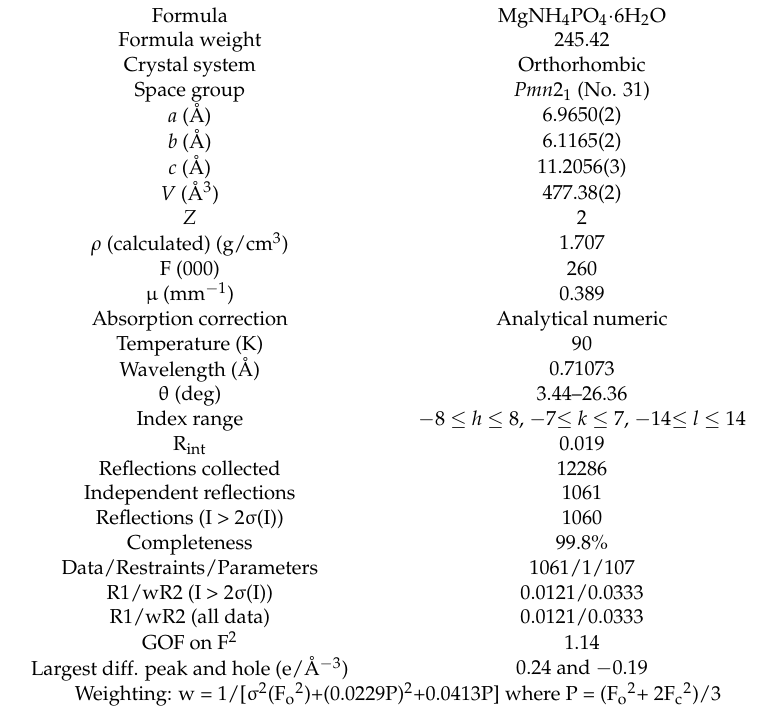
Table 1. Crystal data and structure refinement for